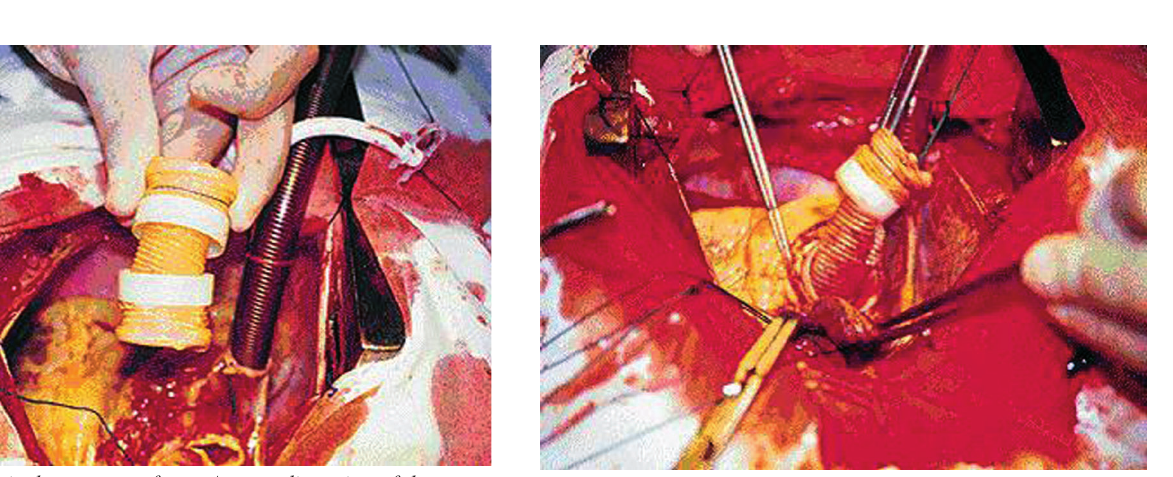
Fig. 2 – Surgical aspect of anastomosed proximal intraluminal